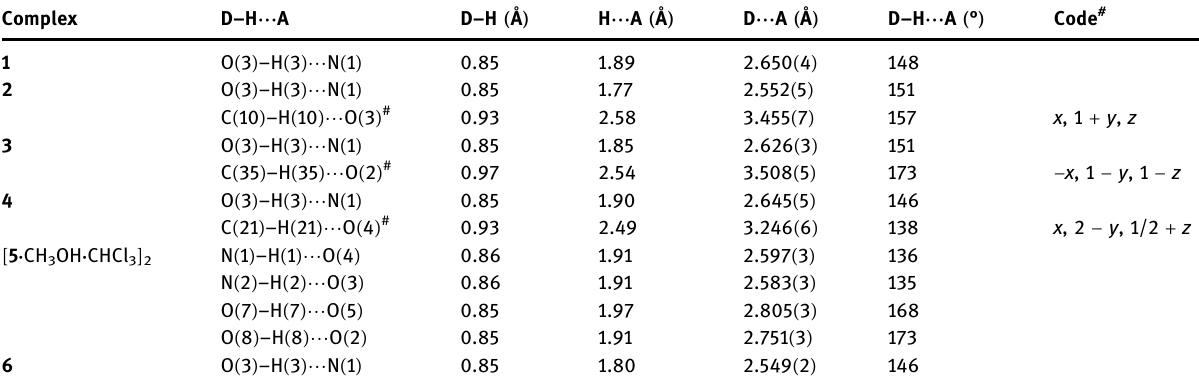
Table 2: H - bonding geometry parameters ( Å, ° ) for the complexes Complex